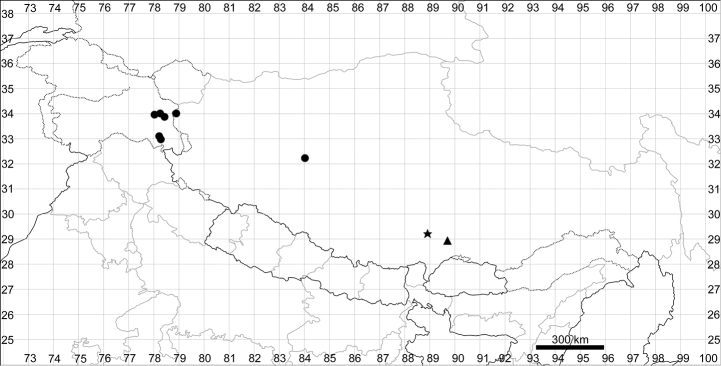
Distribution map of Corispermumdutreuiliivar.dutreuilii (circles), C.pseudofalcatum (star) and C.lhasaense (triangle).